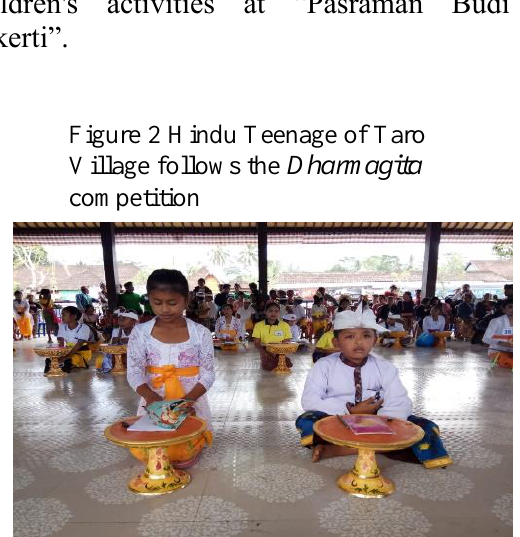
Figure 1 Hindu Teenage of Taro Village participates in the competition to make klangsah and sengkui.